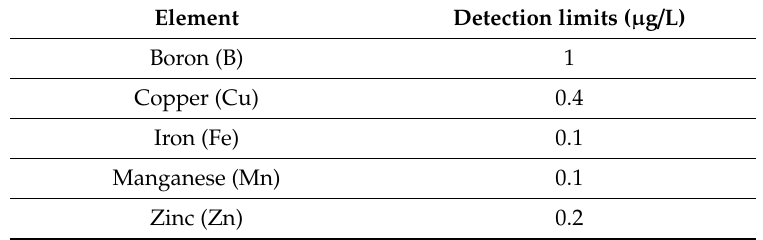
Table A3. Inductively coupled plasma-optical emission spectroscopy (ICP-OES) detection